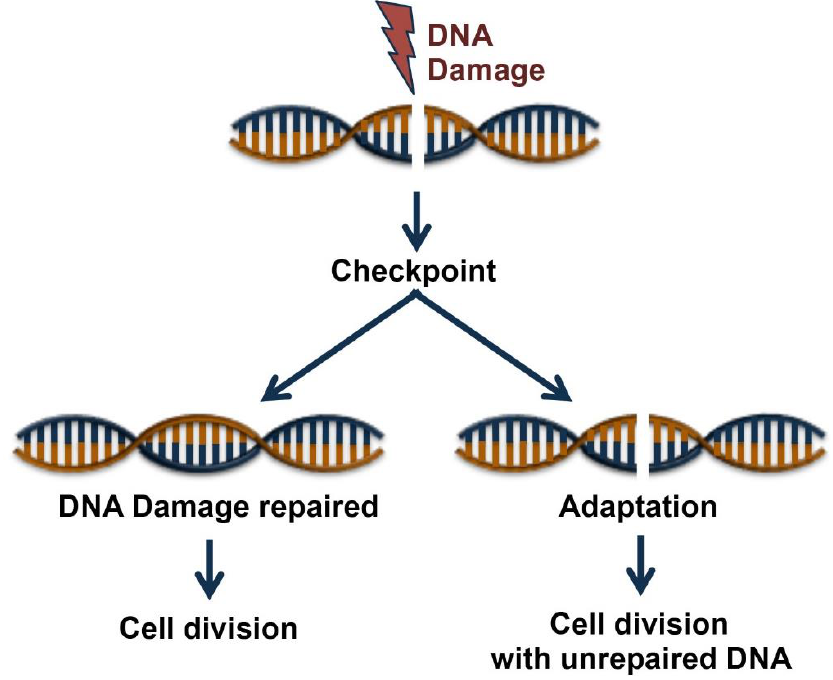
Figure 1. Cell fates following DNA Damage. Cell cycle checkpoint is induced by DNA damage. Cell cycle entry occurs after the DNA damages have been fully repaired, or alternatively, cells have two possible fates, to die or survive after a process of adaptation that allows cell division with unrepaired DNA lesions.